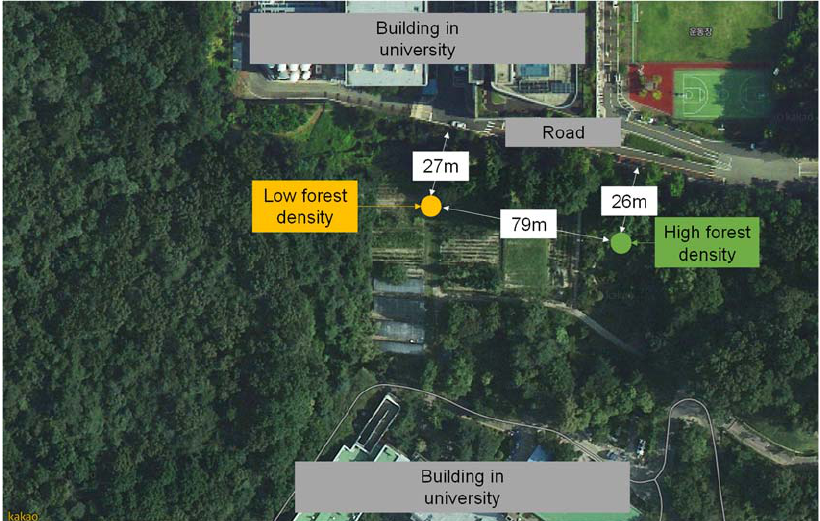
Figure 1. The location of the two experimental sites.